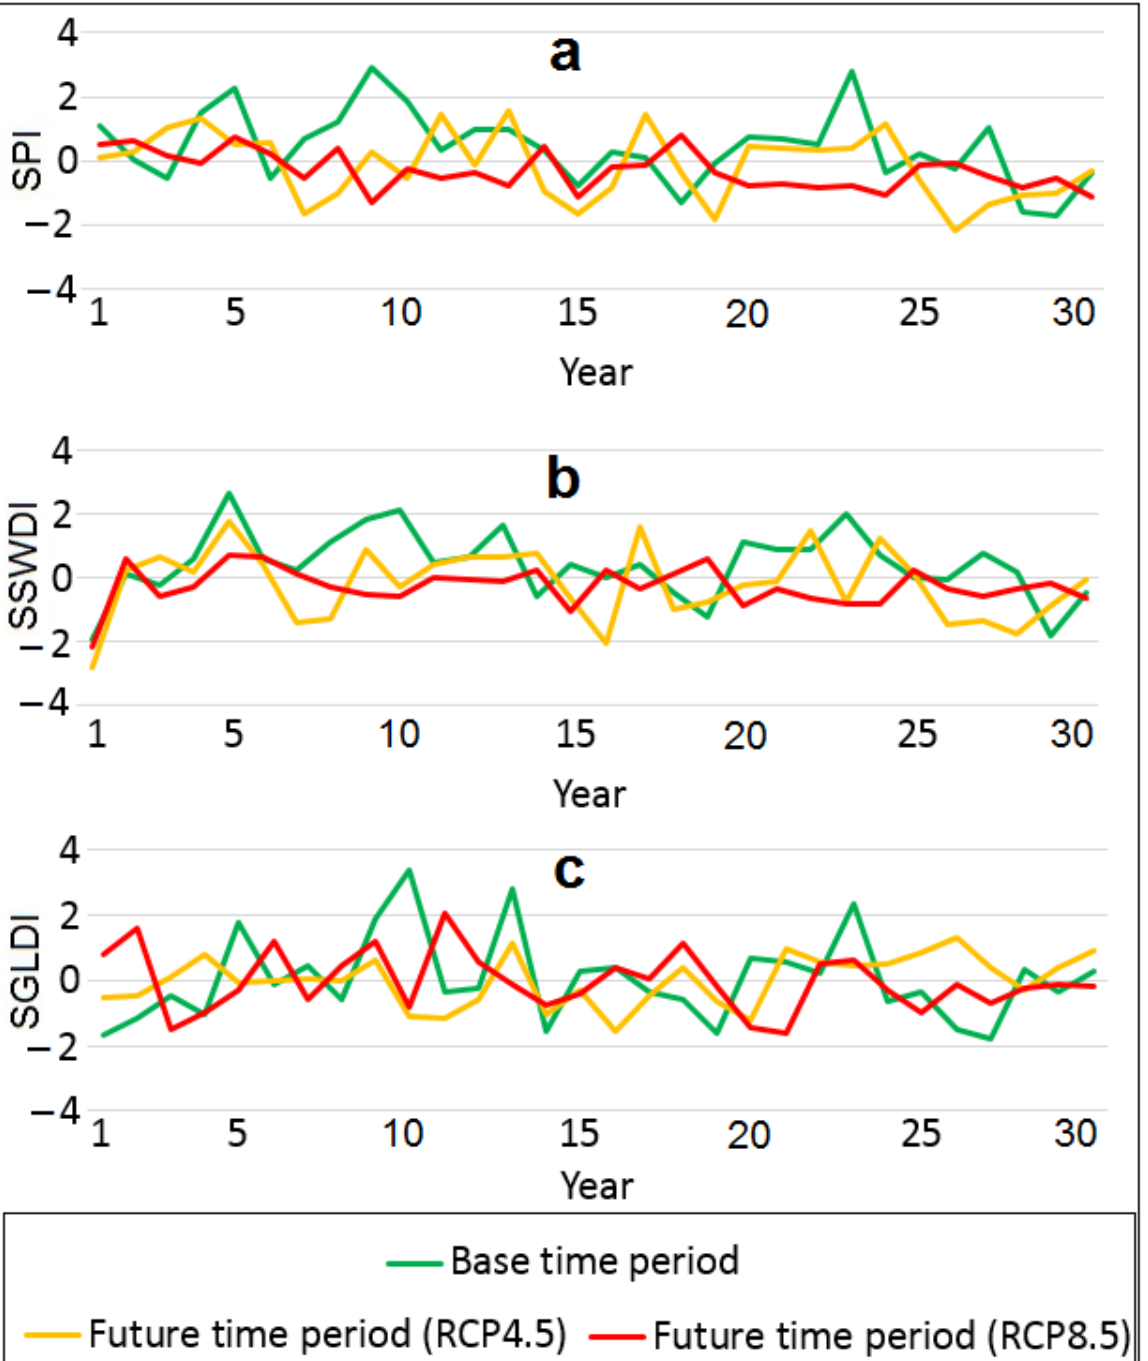
Figure 5. The SPI ( a ), the SSWDI of the Taraz-Harkesh stream ( b ) and the SGLDI of the Bibitarkhoun karst spring ( c ) in the base and future time periods, considering RCP4.5 and RCP8.5 (years 1 – 30 indicate 1961 – 1991, as to the base time period and 2021 – 2050, as to the future time period). Table 3. The SPI, the SSWDI of the Taraz-Harkesh stream and the SGLDI of the Bibitarkhoun karst spring in the base and future time periods, considering RCP4.5 and RCP8.5 (uncolored cells indicate normal ( −0 .99 to 0.99), yellow cells indicate relatively dry ( −1 to −1 .49), orange cells indicate very dry ( −1 .5 to −1 .99), red cells indicate extremely dry (< −2 ), purple cells indicate relatively wet (1 to 1.49), light blue cells indicate very wet (1.5 to 1.99) and dark blue cells indicate extremely wet (>2) condi- tions).